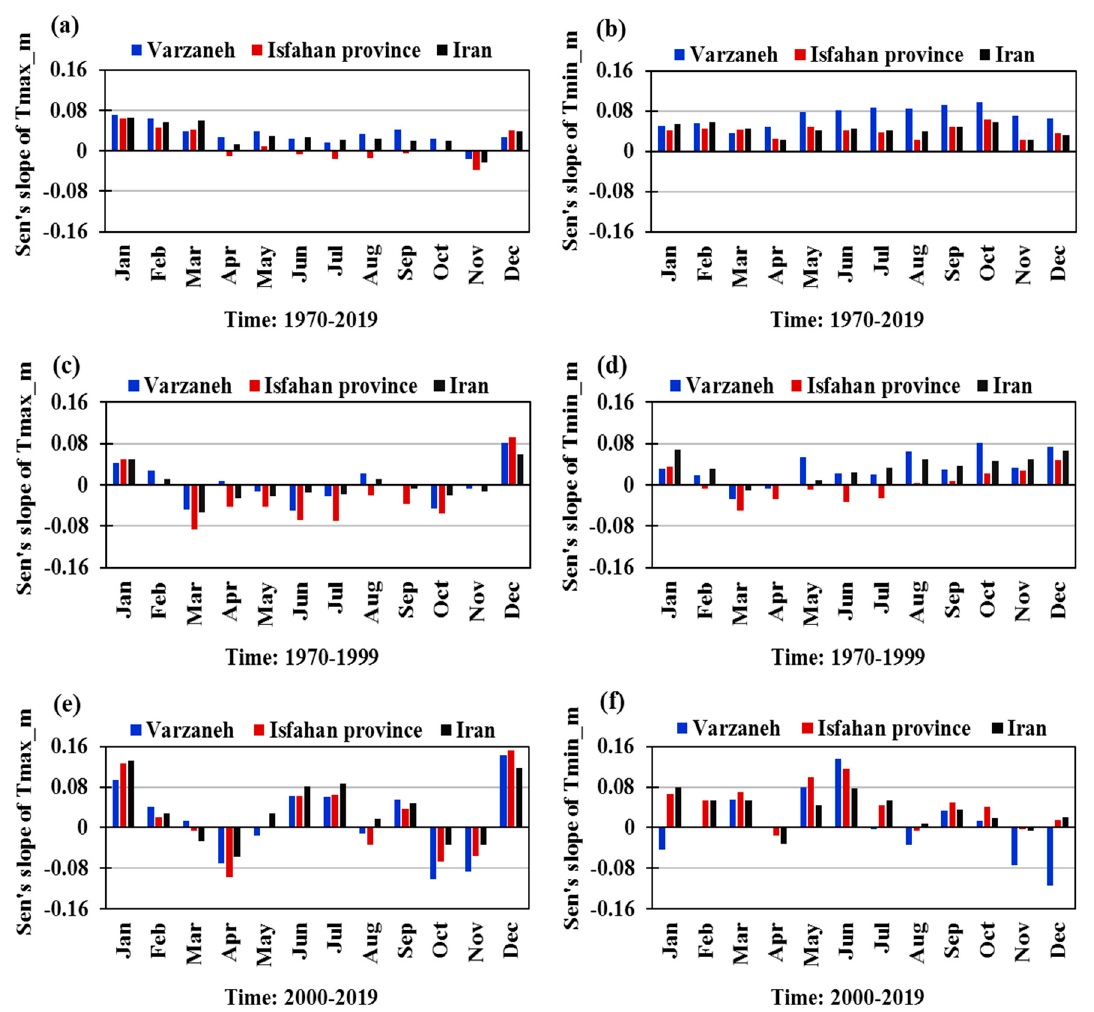
Figure 7. Sens’s slope (°C/year) (Mann ‐ Kendall trend) of monthly observed air temperatures (Tmax_m and Tmin_m) at Varzaneh station, Isfahan province, and Iran, for whole period: 1970–2019: ( a , b ), in the period of 1970–1999: ( c , d ), and in the period of 2000–2019: ( e , f ).